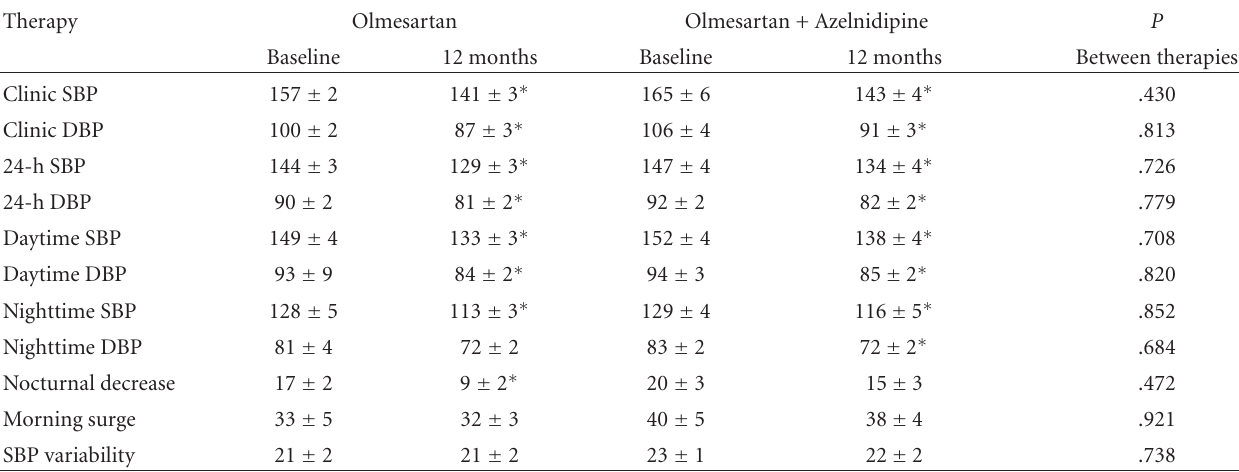
Table 2: Changes in blood pressure during the study period.